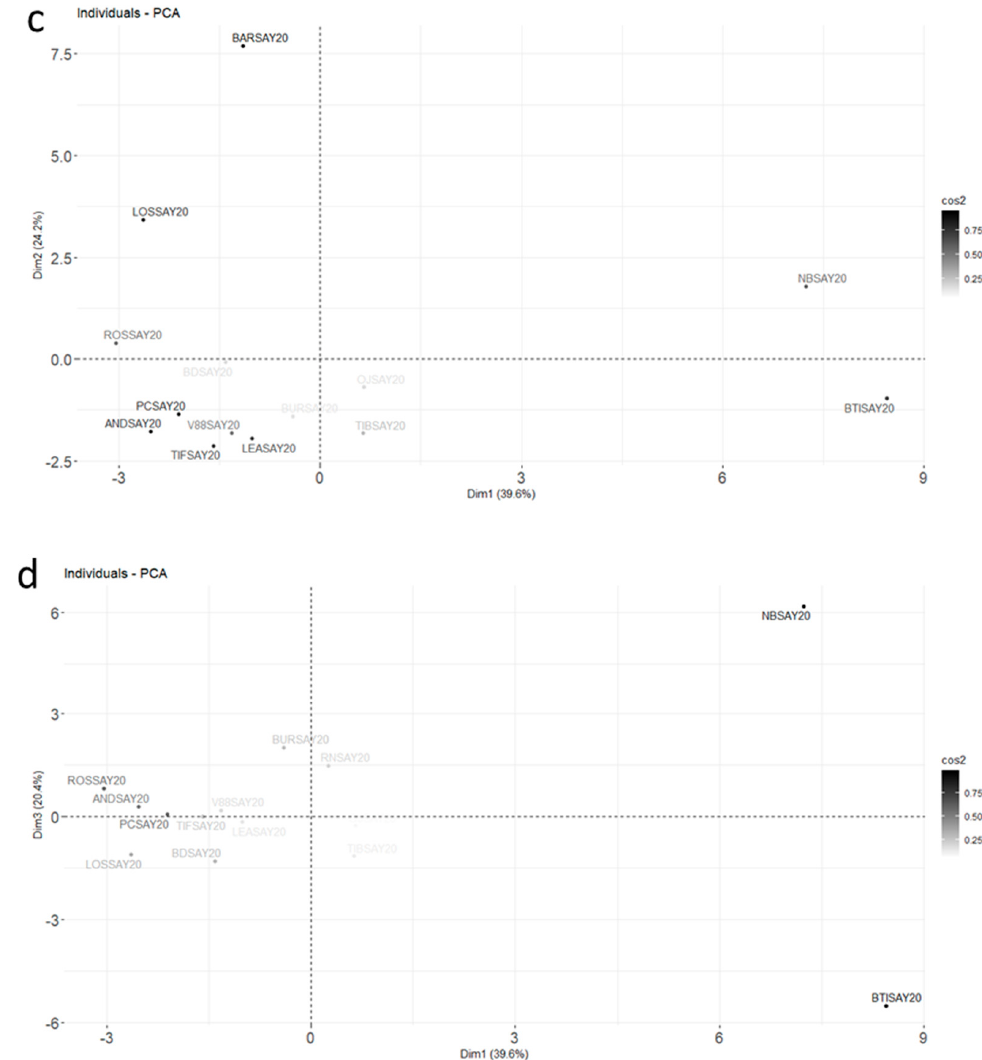
Figure 4. Final PCA plot released for harvest data from 2020 for the molecules retained after RSD sorting and the first PCA (Car indicates 3Car and Aromad indicates 4Aromad). The color gradient represents the level of square cosines for the variables ( a , b ) and the individuals ( c , d ). Variables with poor representation (cos 2 < 0.5) are invisible. The supplementary variable, the Brix degree, is in dashed blue; ( a , b ) correspond to the variable plots in plans Dim 1–Dim 2 and Dim 1–Dim 3, respectively; ( c , d ) correspond to the individual plots in plans Dim 1–Dim 2 and Dim 1–Dim 3, respectively.